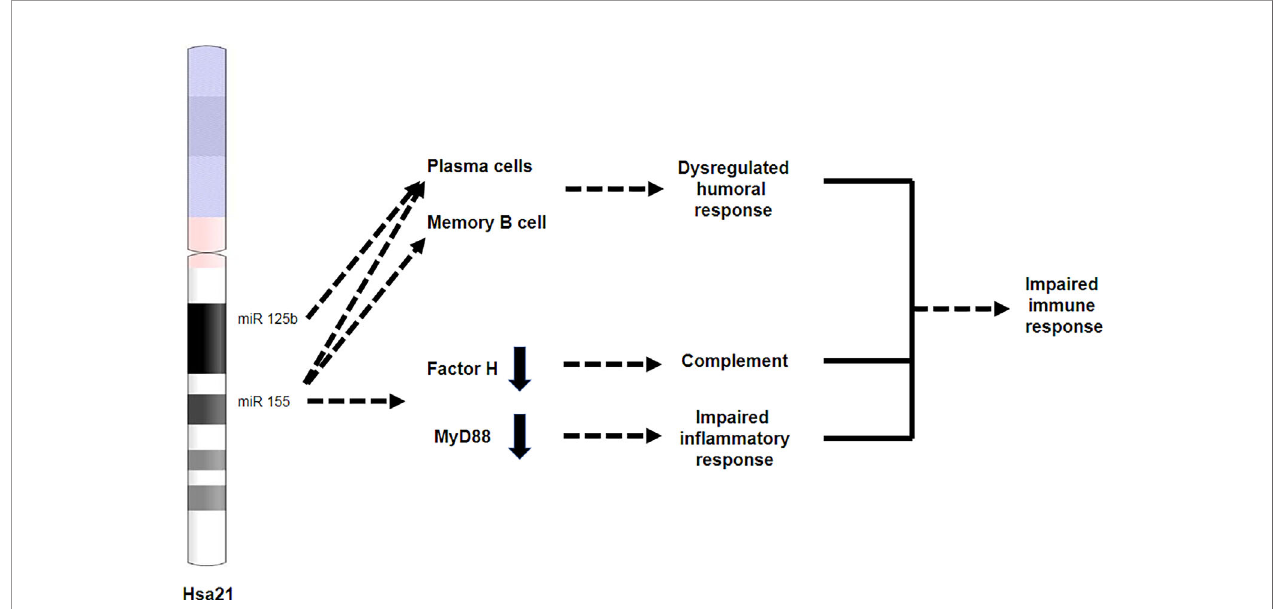
FIGURE 4 | miR-125b and miR-155 are involved in immune dysregulation in DS. Both miR-125b and miR-155 are located on chromosome 21. miR-125b is overexpressed in plasma cells, while miR-155 is overexpressed in both plasma and memory B cells, leading to an impaired humoral response. miR-155 overexpression results in reduced expression of factor H and Myd88, leading to impaired complement response and impaired in fl ammatory response,